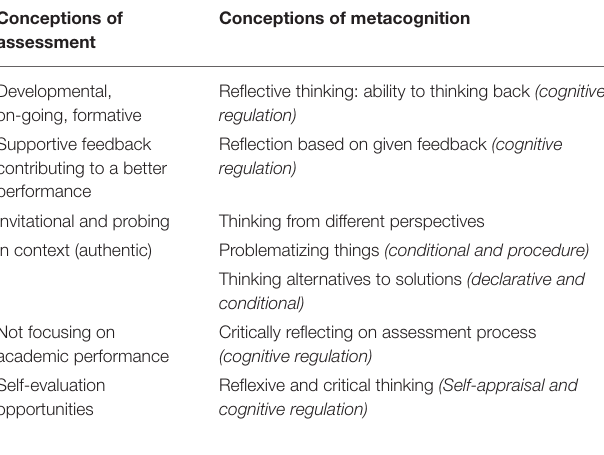
TABLE 4 | Nancy’s conceptions of assessment and metacognition.